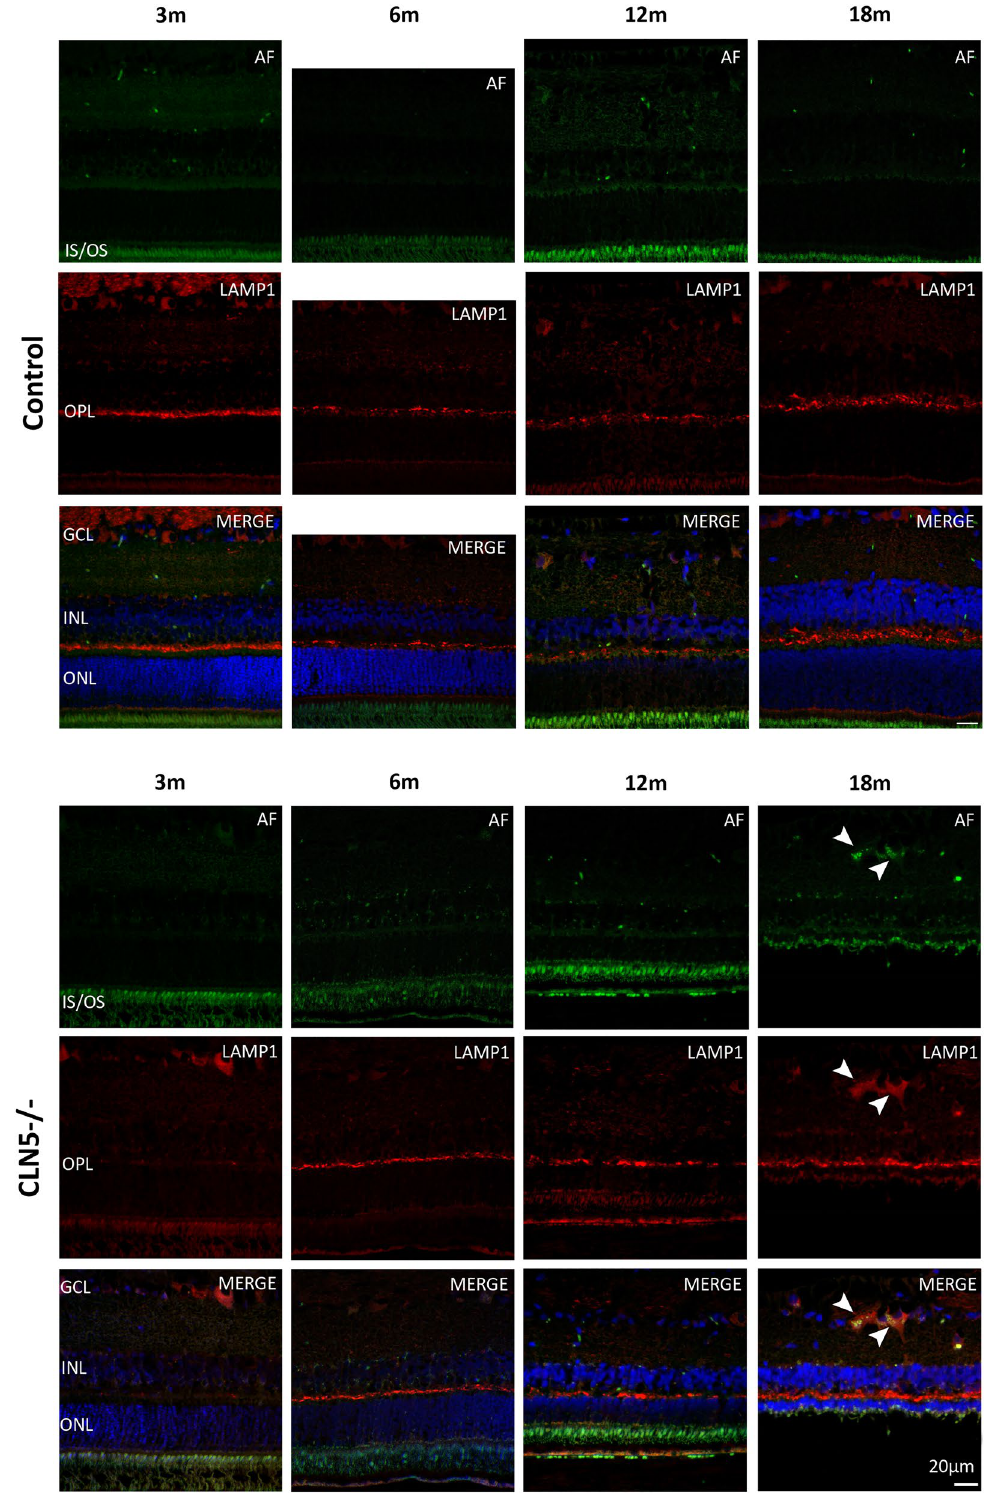
Figure 4. Lysosomal storage burden in the retina of healthy control and CLN5 −/− sheep at different ages. Top panel; Representative confocal images of control central retina. Bottom panel; Representative confocal images of CLN5 −/− central retina. AF; autofluorescence (green). LAMP1; lysosomal-associated membrane protein 1 (red). Merged image shows AF and LAMP1 with DAPI nuclei stain (blue). Arrowheads highlight co-localisation of AF and LAMP1, indicating lysosomal storage in the CLN5 −/− retina at 18 m (m; months of age). GCL; ganglion cell layer, INL; inner nuclear layer, OPL; outer plexiform layer, ONL; outer nuclear layer, IS/OS; inner and outer segments of photoreceptors. Scale bar 20